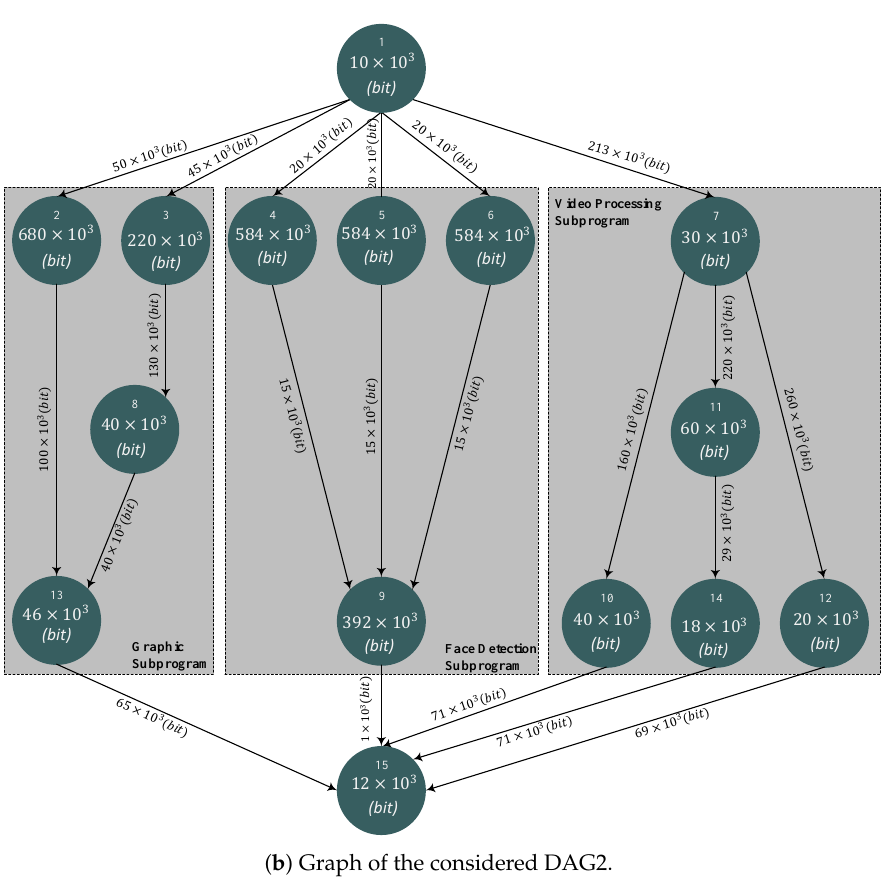
Figure 5. Graphs of the tested DAGS. ( a ) DAG1 and ( b ) DAG2. All the numeric labels are in Kbit. The total workload (e.g., summation of the node labels) and inter-node traffic (e.g., summation of the edge weights) of the test DAGs are the same. They equate to 3.32 (Mbit) and 1.66 (Mbit),